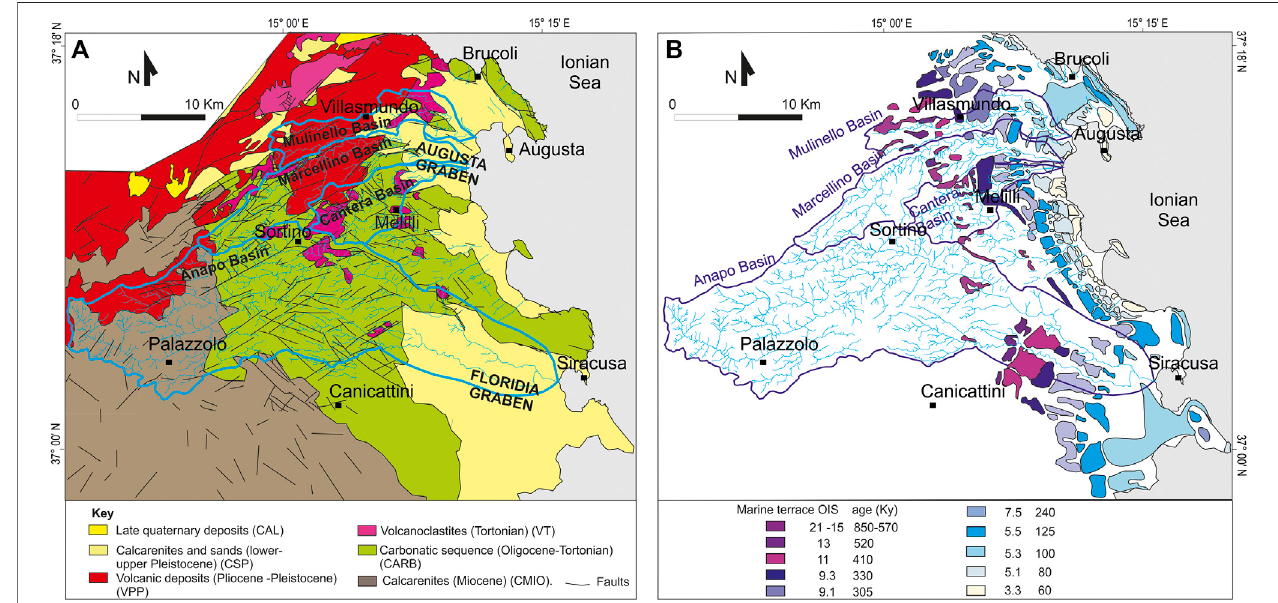
FIGURE 2 | (A) Geological sketch map of the study area (modi fi ed after Lentini et al., 1994) and the analyzed fl uvial basins: from north to south the Mulinello, Marcellino, Cantera and Anapo Rivers; cyan and light blue (B) lines represent the watersheds of the studied rivers. (B) Marine terraces (modi fi ed after Catalano et al., 2010) and the fl uvial network of the analyzed